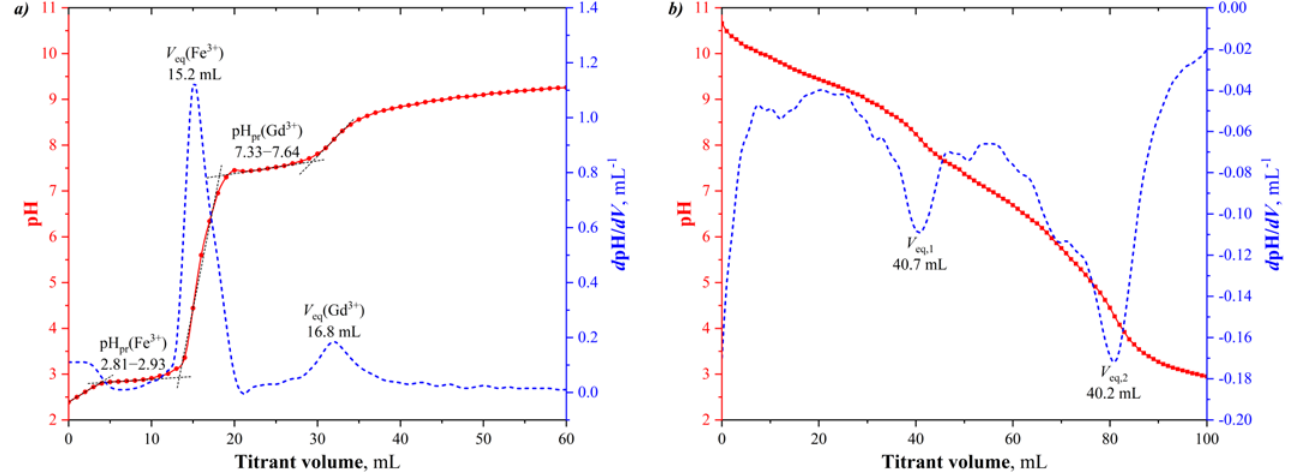
Figure 2. Direct and reverse titration curves: titration of gadolinium and iron(III) nitrates with ammonia ( a ) and titration of ammonia with gadolinium and iron(III) nitrates ( b ).